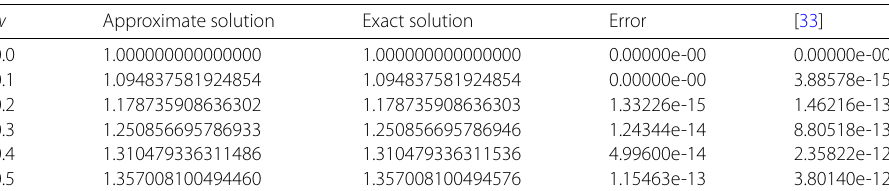
Table 5 Comparison of approximate and exact solution and absolute error of Example 5.5 when J = 4